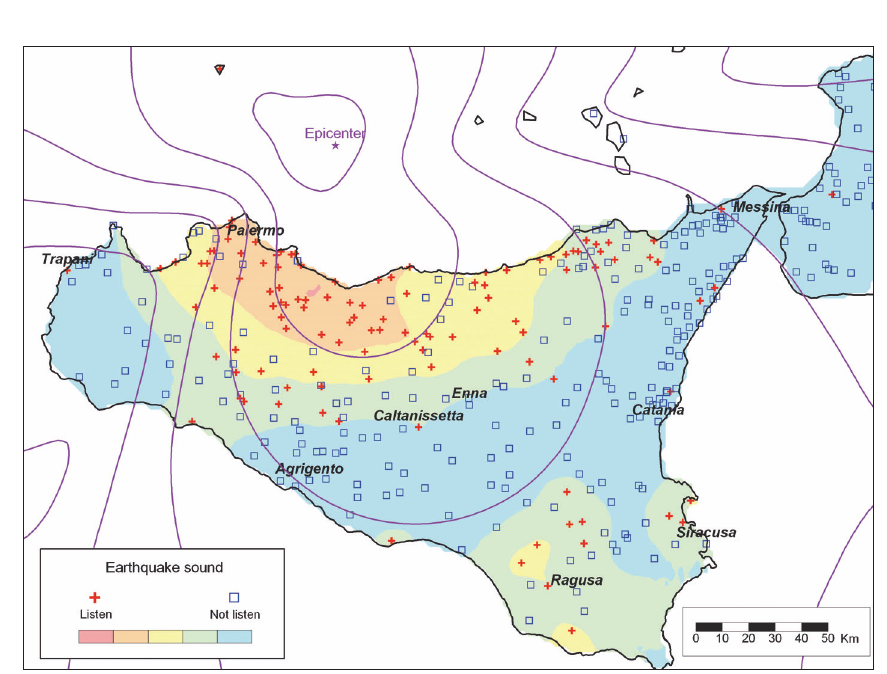
Fig. 2. Earthquake sound heard. Original data with its interpolated and smoothed spatial reconstruction (color shading), compared with the theoretical sound pressure level in relative values (violet contour of equidistance 10 dB) obtained using focal mechanism